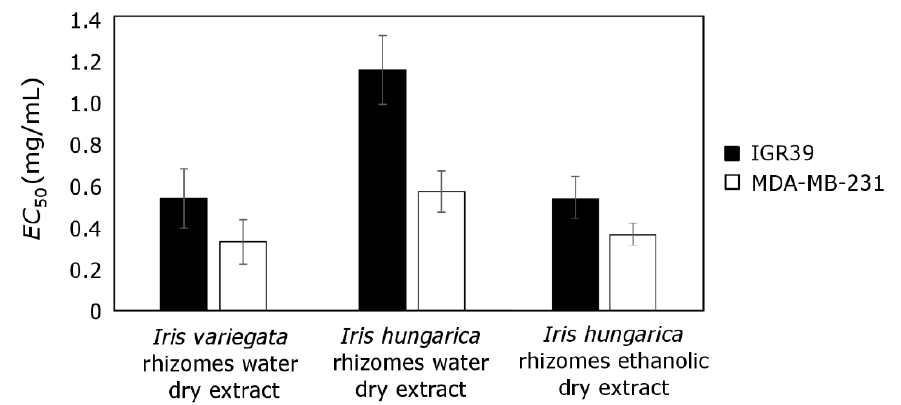
Figure 5. Cytotoxic effect of the tested extracts against melanoma (IGR39) and triple-negative breast cancer (MDA-MB-231) cell lines. I. variegata rhizomes water extract, I. hungarica rhizomes water extract and I. hungarica rhizomes ethanolic (70% EtOH) extract were tested. The values are expressed as EC 50 values, indicating concentrations causing a 50% reduction in viability of the cells ( n =